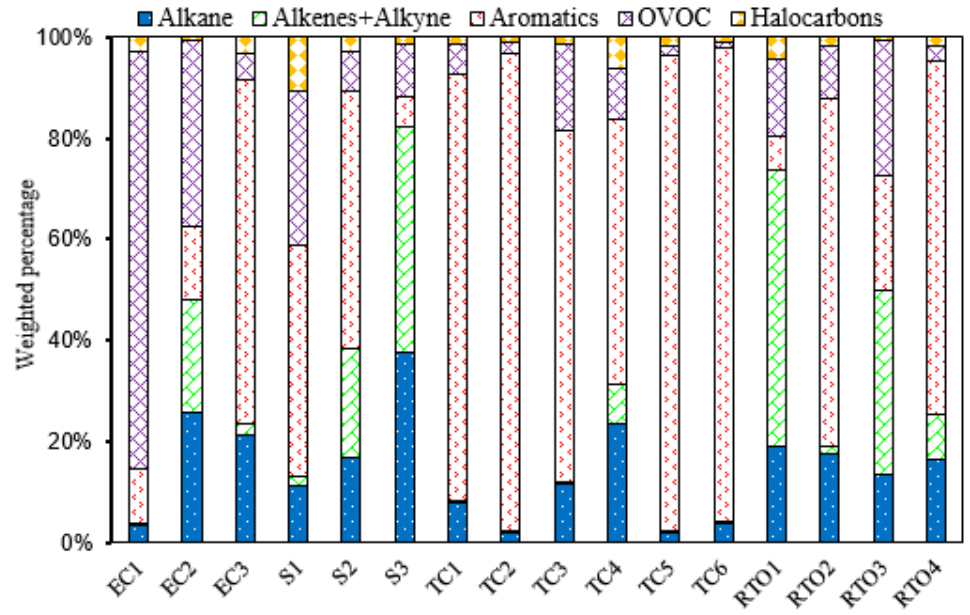
Figure 5. Overall VOC chemical group patterns of four major sectors in auto manufacturing industry.